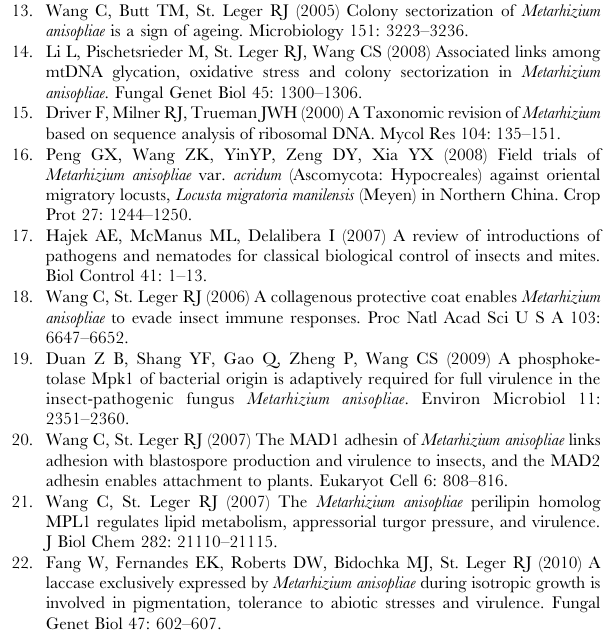
Table S17 The number of genes coding for transcription factors in Metarhizium anisopliae and M. acridum , arranged by family.